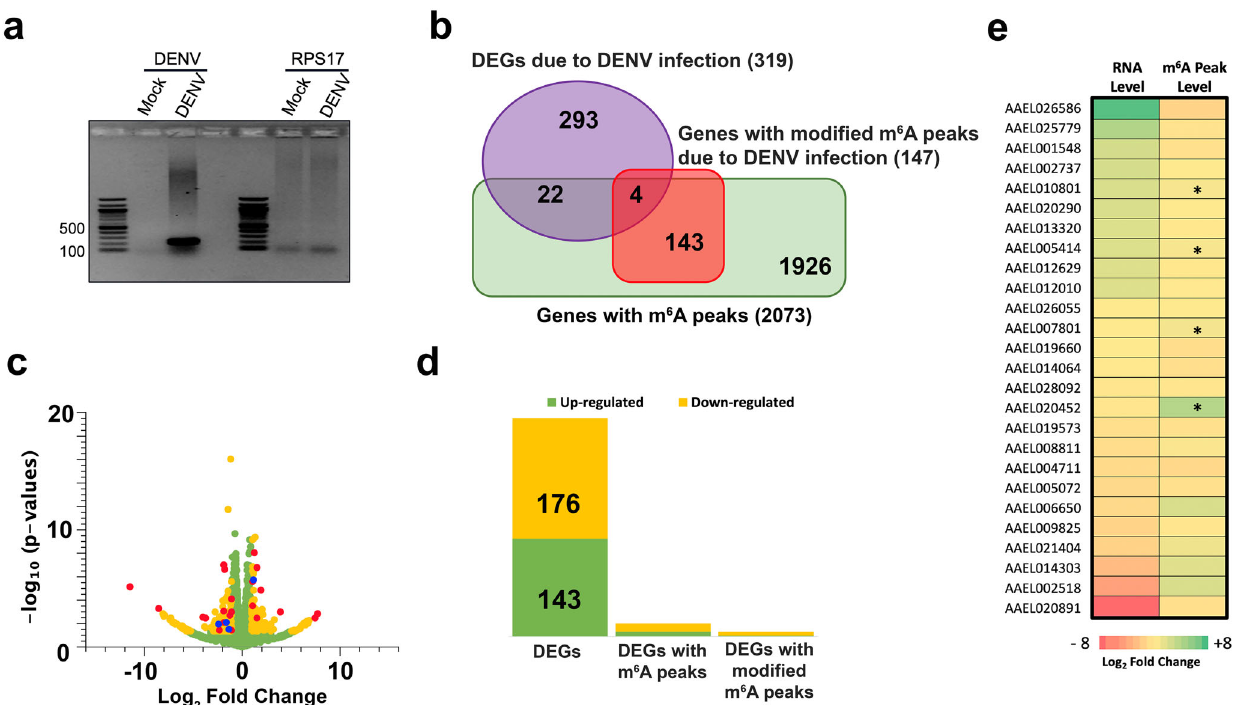
Fig. 3 Dengue virus infection alters m 6 A modi fi cation of Ae. aegypti transcripts. a Con fi rmation of DENV infection of Aag2 cells. RT-PCR analysis of RNA extracted from Aag2 (Mock) and Aag2 cells infected with 1 MOI DENV 5 days after infection using DENV-speci fi c and RPS17 (control) primers. The PCR products were analysed on an agarose gel. b Venn diagram showing summarized numbers of differentially expressed genes, with and without m 6 A peak changes. c Volcano plot showing differentially expressed genes in Aag2 cells in response to DENV infection. Green and yellow dots represent up-regulated and down-regulated genes with fold change >2 and p value <0.05, and those in red and blue are DEGs with m 6 A peaks, with the blue ones being DEGs with changed m 6 A peaks upon DENV infection. d Number of signi fi cantly differentially expressed genes between mock and DENV-infected Aag2 cells at fi ve days post infection among which there were 26 with m 6 A peaks, of which four showed modi fi ed m 6 A upon DENV infection. e Heatmap of Ae. aegypti genes with m 6 A sites, which were differentially expressed in response to DENV infection (see Table 1 for the list of genes). The four genes that showed differential m 6 A and gene expression upon DENV infection are indicated by